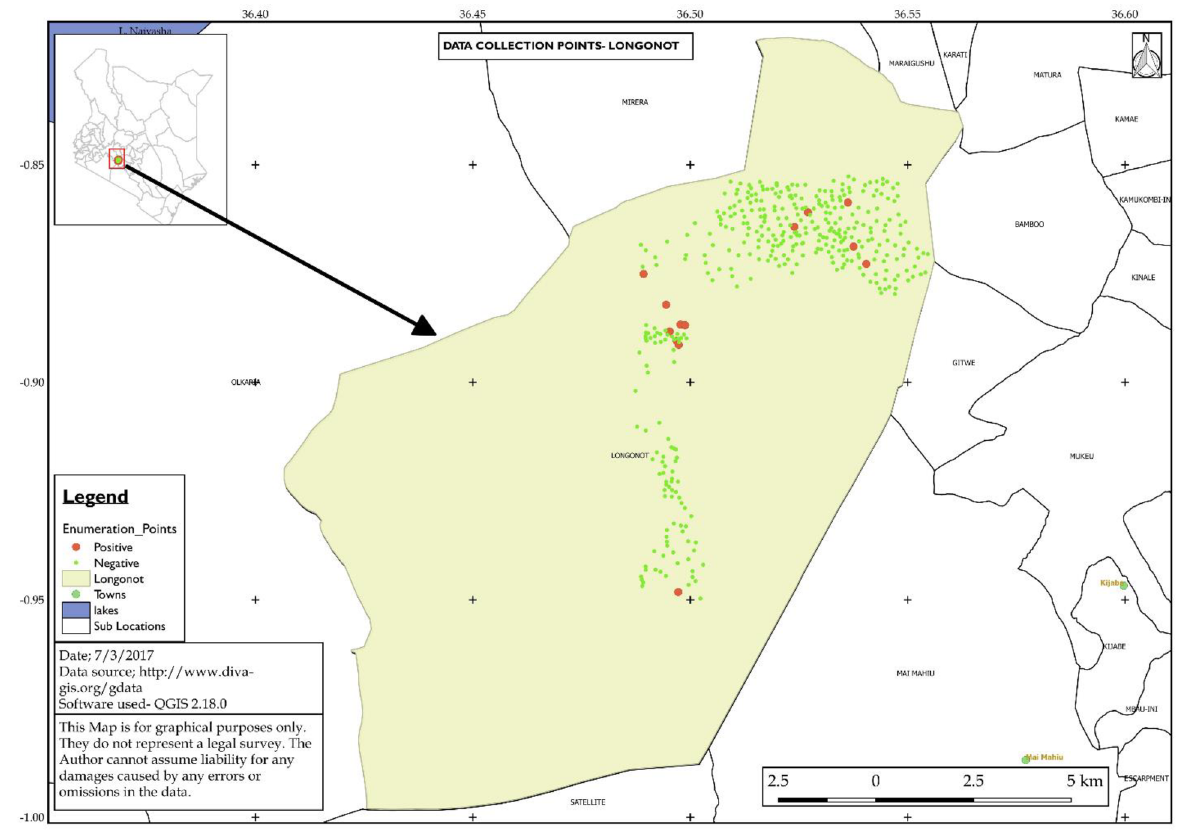
Fig 1. Study site showing the selectedstudy households. Big red dots indicateclinicallypositive households whilethe small green dots indicate clinicallynegativehouseholds. Top left hand is a map of Kenya showingthe location of Mt Longonot area.